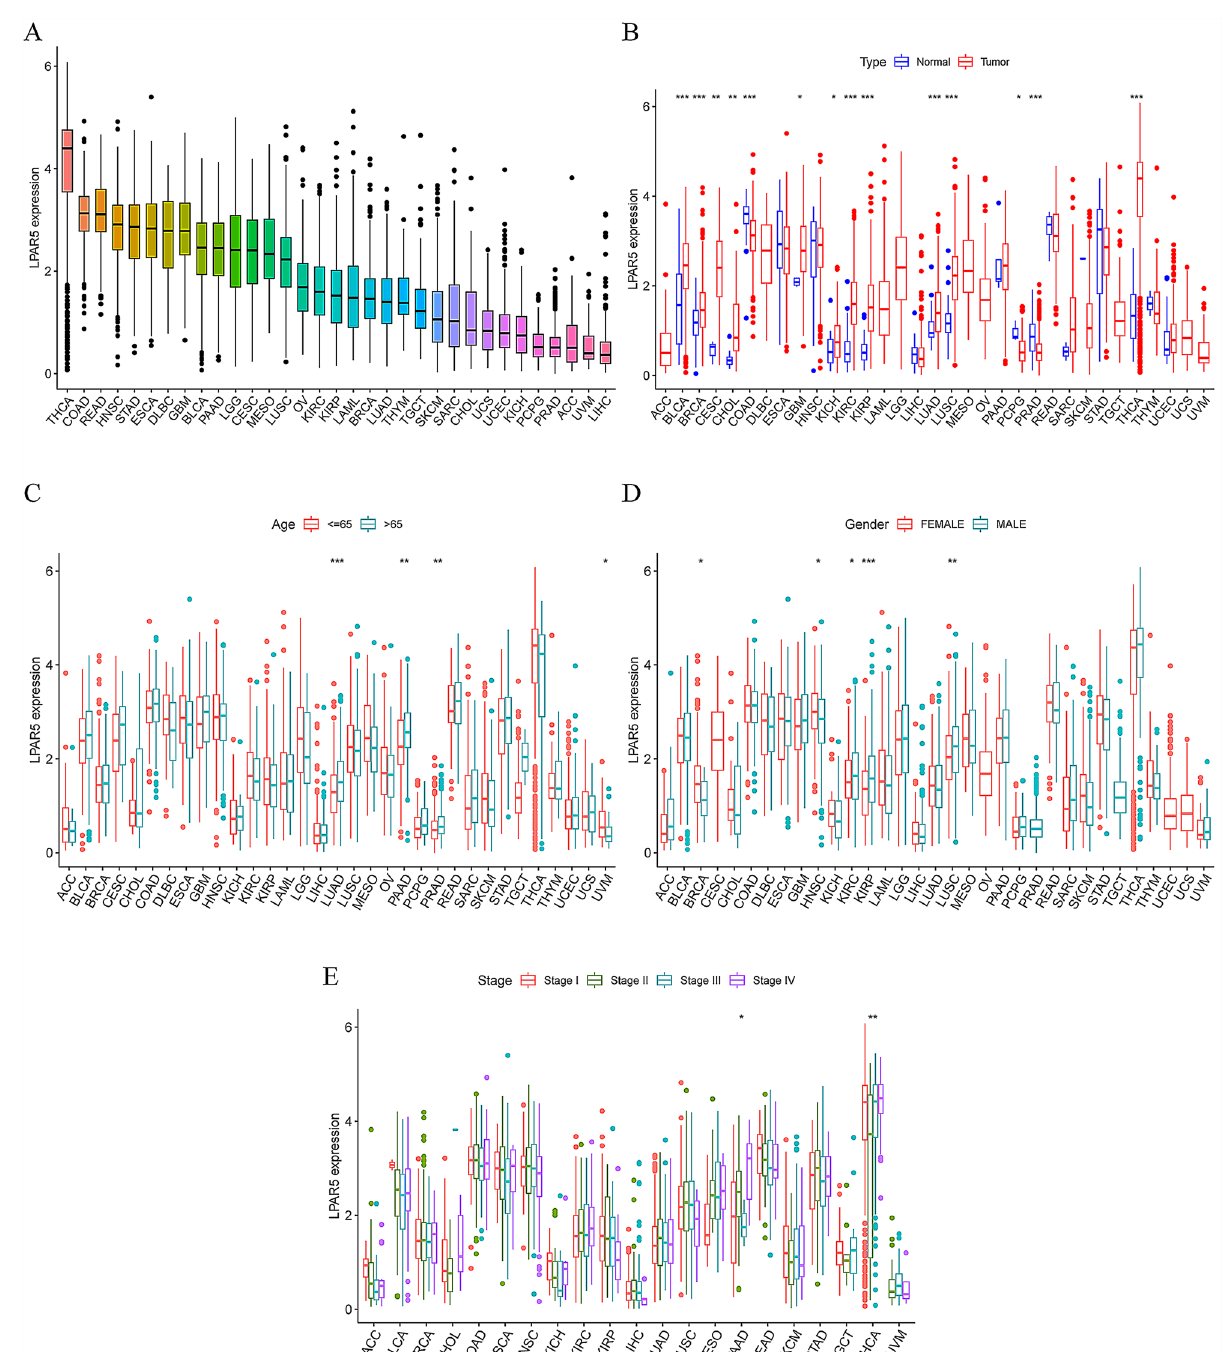
Figure 5. LPAR5 expression in 33 cancers. ( A ) LPAR5 expression levels in 33 different types of cancer. ( B ) LPAR5 expression levels in tumor samples and adjacent normal samples of 33 different types of cancer. ( C ) LPAR5 expression levels correlated with age in 4 of 33 different types of cancer. ( D ) LPAR5 expression levels correlated with gender in 5 of 33 different types of cancer. ( E ) LPAR5 expression levels correlated with stage in PAAD and THCA. [Figures created by R, version